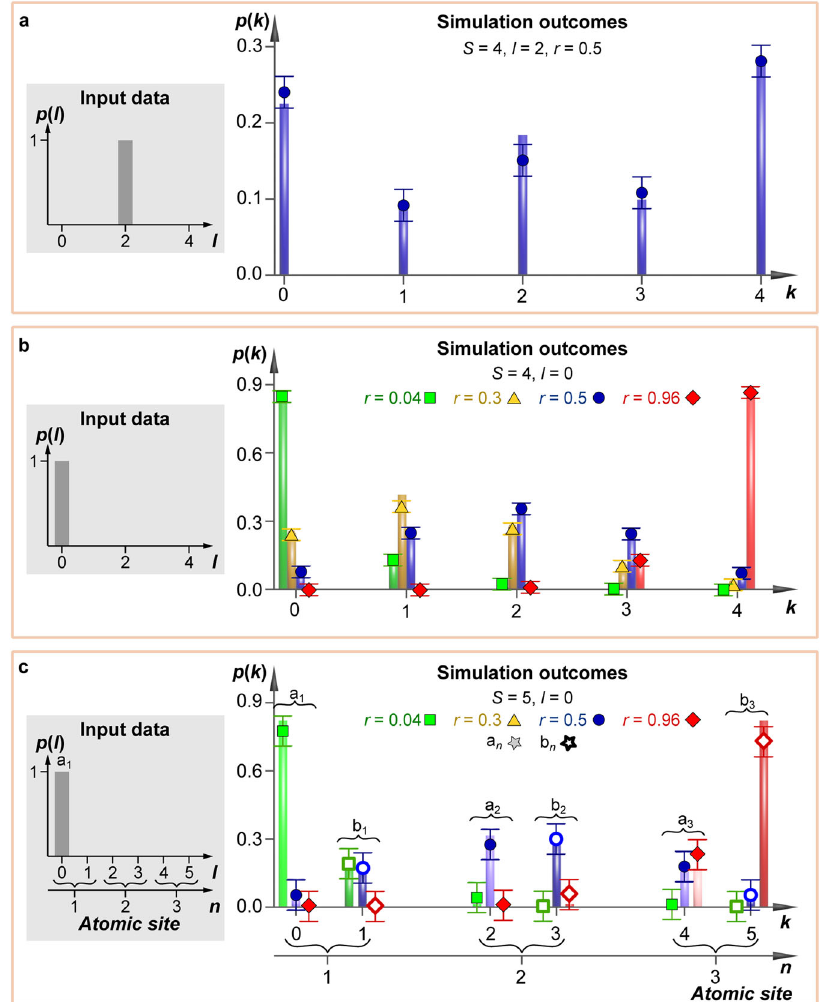
Fig. 4 Measured Fock state quantum simulations. The experimental simulation outcomes (symbols with error bars) are the directly and S (cid:2) l j i , on a beam splitter of re fl ectivity r . The grey insets measured photon statistics p ( k ) resulting from interference of Fock states, l j i a b display the input data l , while the bars expected theoretical values of p ( k ) obtained numerically. a Two two-photon Fock states ( S = 4, l = 2) interfering on a balanced beam splitter ( r = 0.5) reveal an edge-state structure in the corresponding spin chain. b Interference of the vacuum and a four-photon number state ( S = 4, l = 0) observed for several gradually increasing re fl ectivities r = 0.04 (green squares), 0.3 (orange triangles), 0.5 (blue circles) and 0.96 (red diamonds) models perfect wave packet transfer in the Kravchuk chain. c Interference of the vacuum and a fi ve-photon number state ( S = 5, l = 0) observed for the same set of re fl ectivities models the transfer of Majorana fermions a n and b n across a p-wave superconducting chain of 3 sites. Errors were estimated as a square root inverse of the number of